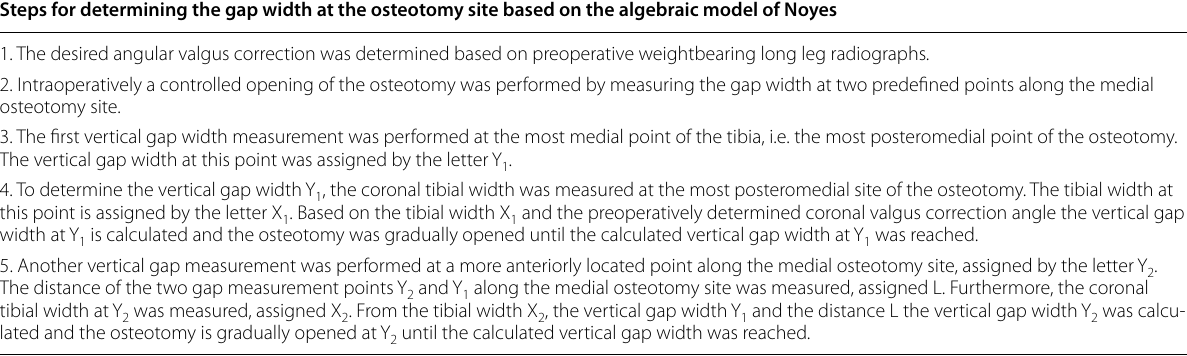
Performed intraoperative steps for obtaining proper vertical gap opening at the osteotomy site according to the algebraic method proposed by Noyes.